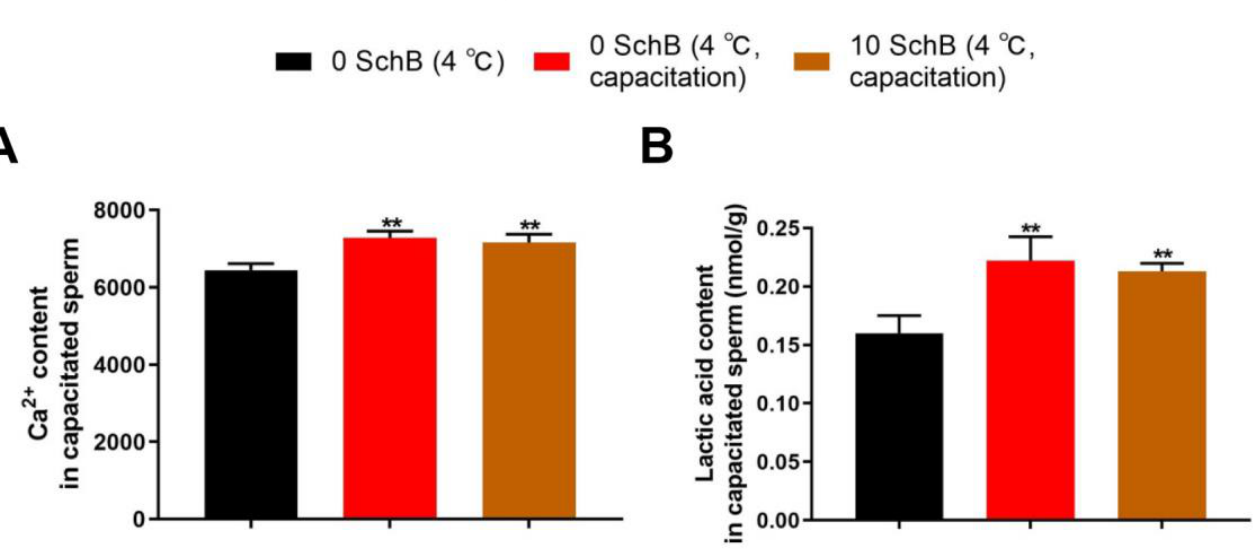
Figure 8. Effects of Sch B on PKA ( A ) and PKG Levels ( B ) in boar sperm: Data are expressed as mean ± SD ( n = 12). # p < 0.05 vs. 0 Sch B, * p < 0.05 vs. fresh.